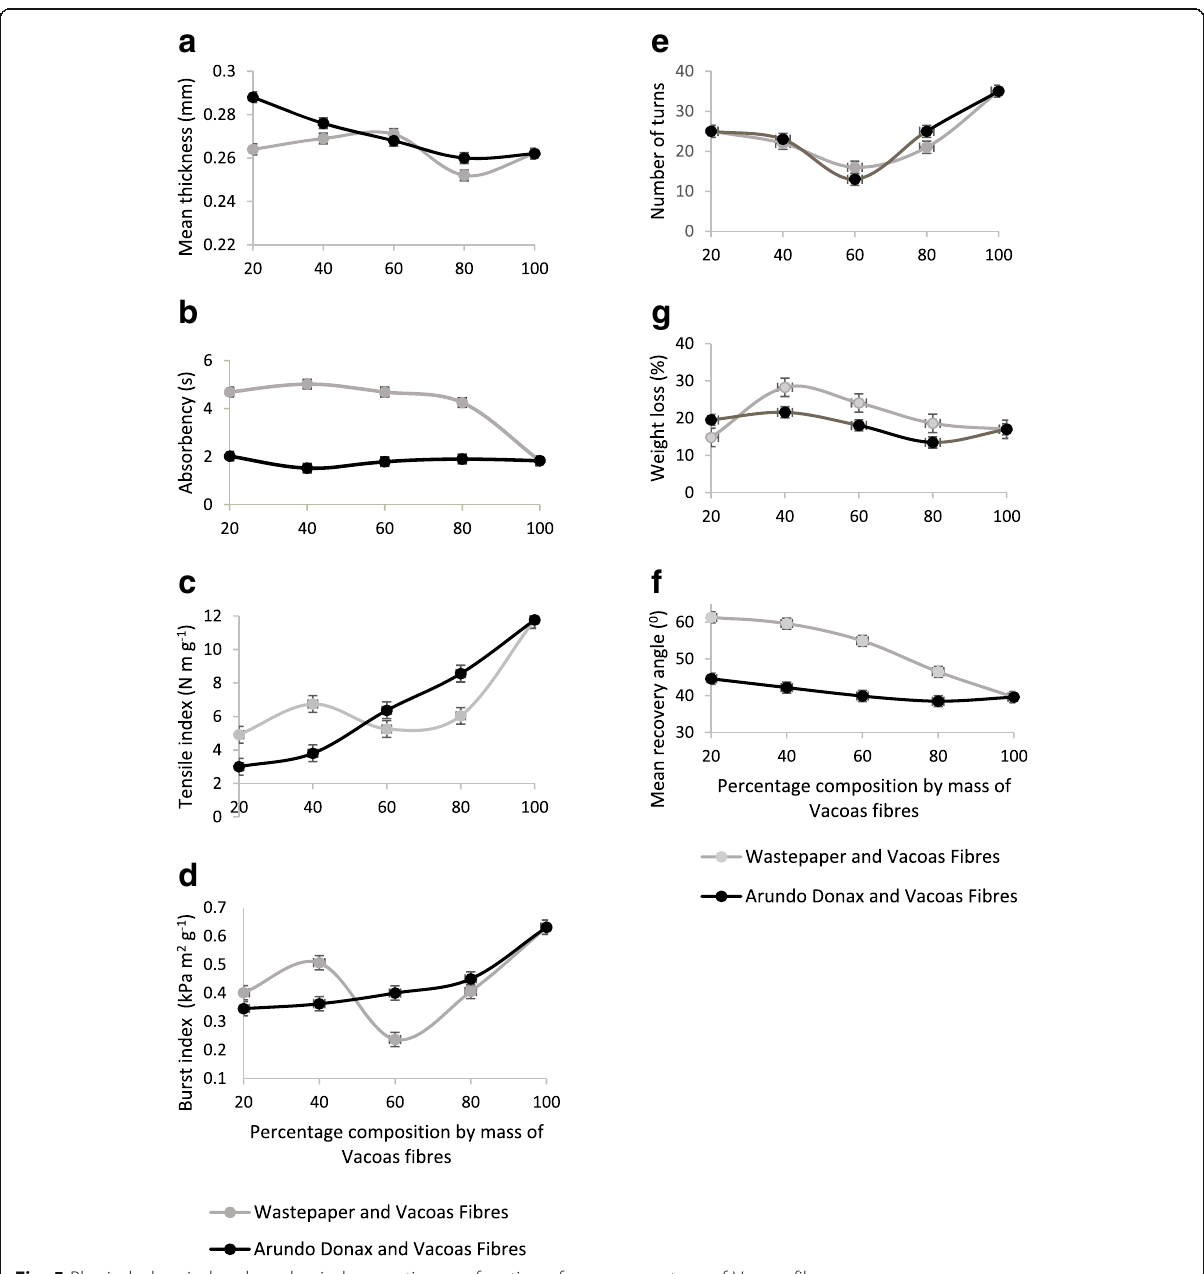
Fig. 5 Physical, chemical and mechanical properties as a function of mass percentage of Vacoas